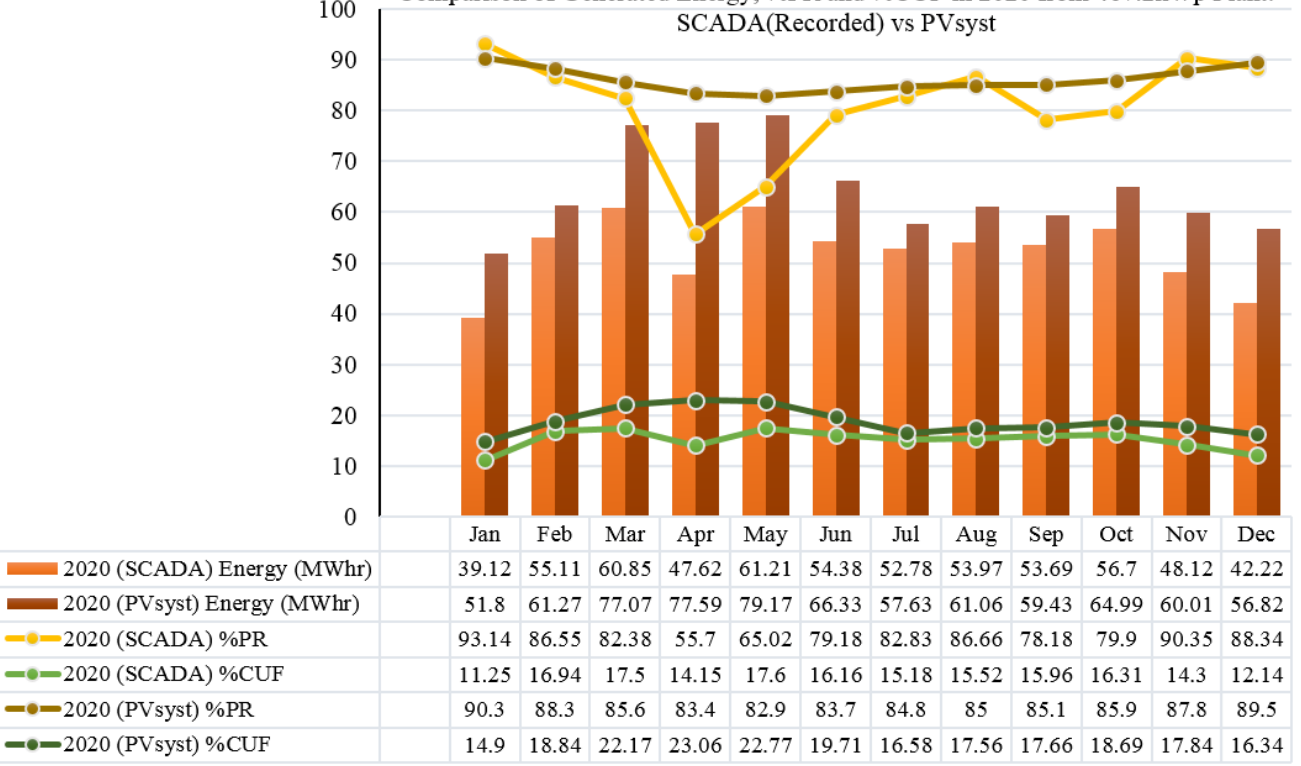
Table 10 . Performance parameters of SPV plants reported in published literature compared with installed site at Integral University .